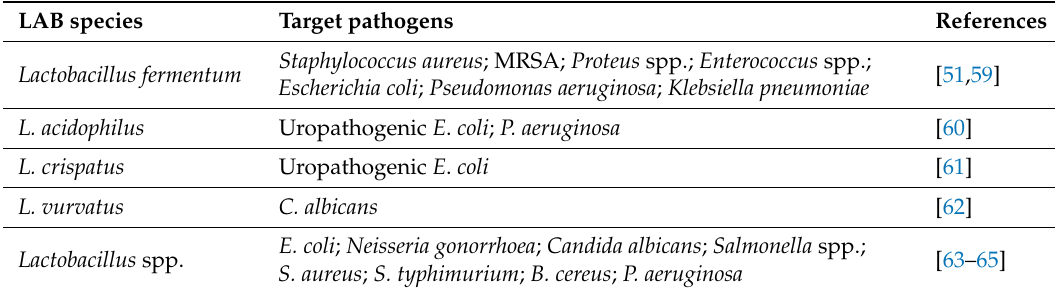
Table 2. In vitro studies of antimicrobial activities of LAB isolates against